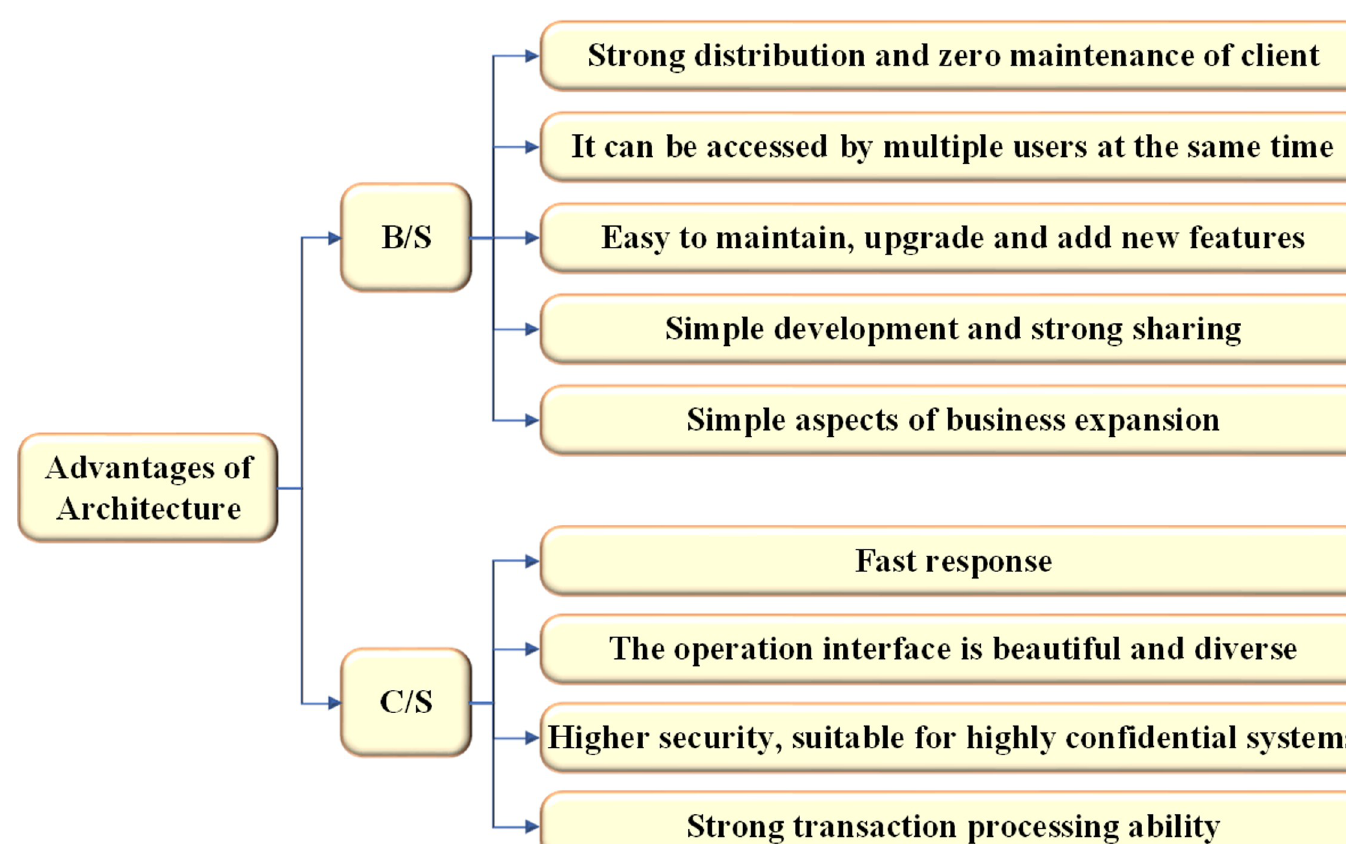
Fig 3. Comparison between advantages of B/S architecture with C/S